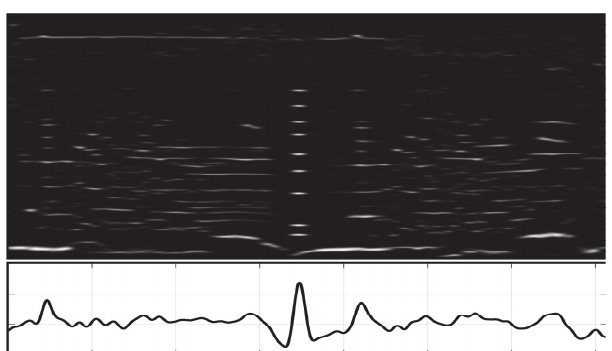
Fig. 2. Smoothing result of one of 2DE gel images by asymmetrical Gaussian filter with illustrated graph of pixel intensity accumulation result for each image matrix column.